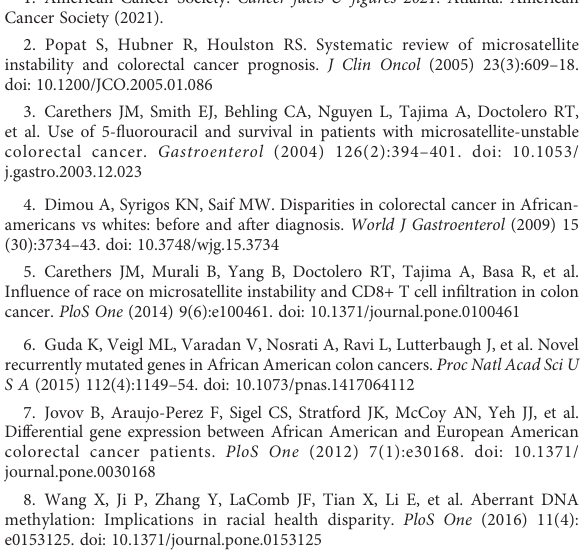
SUPPLEMENTARY FIGURE 1 IL-1 b induces proliferation in AA and CA colon cancer cell lines. Changes in cell proliferation were detected via MTS Assay in both AA and CA colon cancer cell lines. Cells were seeded in media containing increasing concentrations of IL-1 b (1, 5, 10, 30, 60 ng/ml) and changes in cell viability were detected after 96 hours. MSS cell lines (CHTN-96 and HT- 29) (A) , MSI cell lines (SB-521 and HCT-116) (B) . Data representative of three independentexperiments. ErrorbarsrepresentSEM. *p< 0.05, **p< 0.01, ***p < 0.001. SUPPLEMENTARY FIGURE 2 IL-1Ra inhibits IL-1 b -induced proliferation in colon cancer cell lines. Cells were seeded in media without (Control and IL-1Ra) or with (IL-1 b and IL- 1 b + IL-1Ra) 10 ng/ml of IL-1 b and incubated for 24 hours. The following day IL-1Ra (10 ug/ml) was added and treatment was carried out for 24 hours (A) ,48hours (B) and72hours (C) .Cellviabilitywasdetected via MTS assay. Data are representative of three independent experiments. Error bars represent SEM. *p<0.05, **p<0.01,